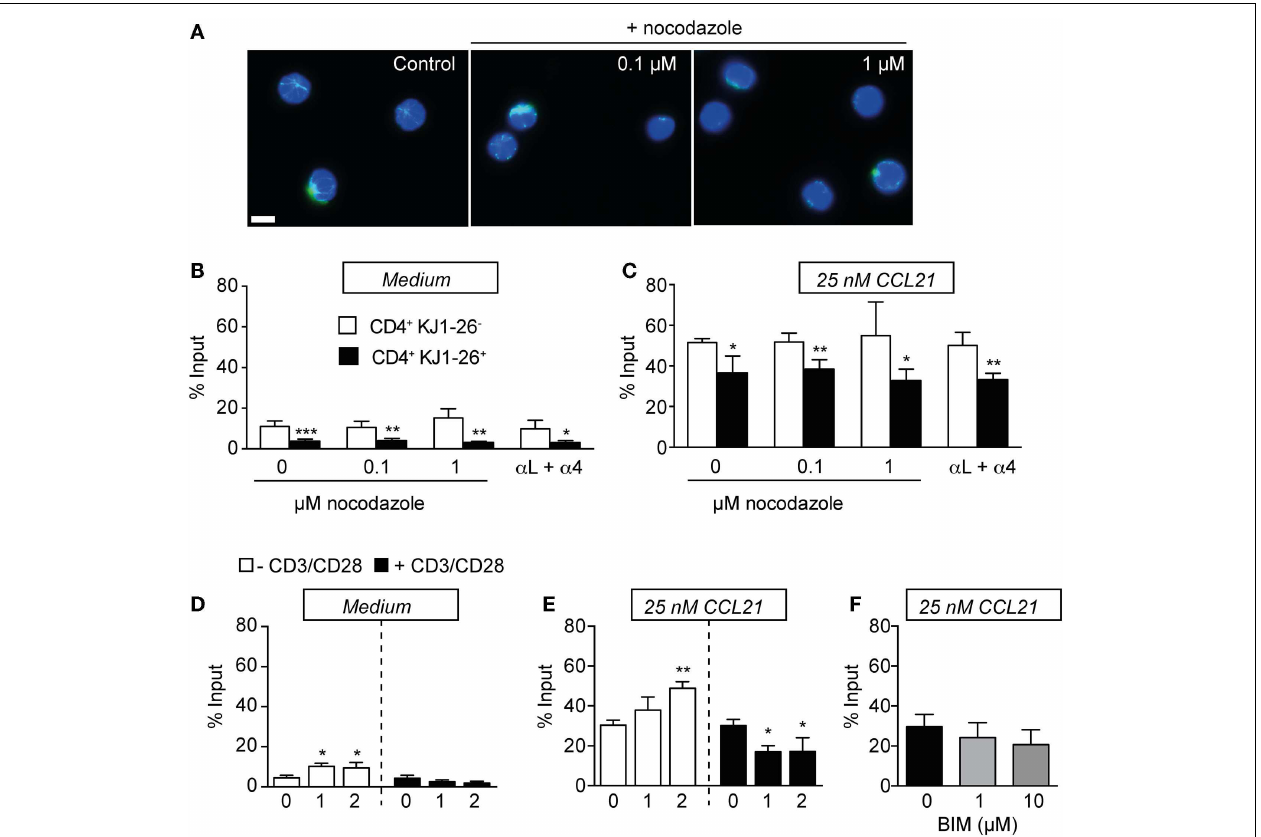
FIGURE 5 | Activation-induced decrease in T cell motility is maintained in the presence of microtubule destabilization agents, integrin blocking, and PKC inhibition . (A) Immunofluorescent analysis of microtubule networks (green) of CD4 + T cells in the presence or absence of nocodazole. Nuclei are labeled with DAPI (blue). Scale bar, 5 µ m. (B) Chemokinesis of endogenous CD4 + versus KJ1–26 + DO11.10 CD4 + T cells on day 3 after OVA/CFA immunization in the presence of nocodazole or integrin-blocking mAbs. (C) Chemotaxis to 25nM CCL21. (D) Chemokinesis of day 2 in vitro -activated lymphocytes mixed 1:20 with non-activated lymphocytes. (E) Chemotaxis of